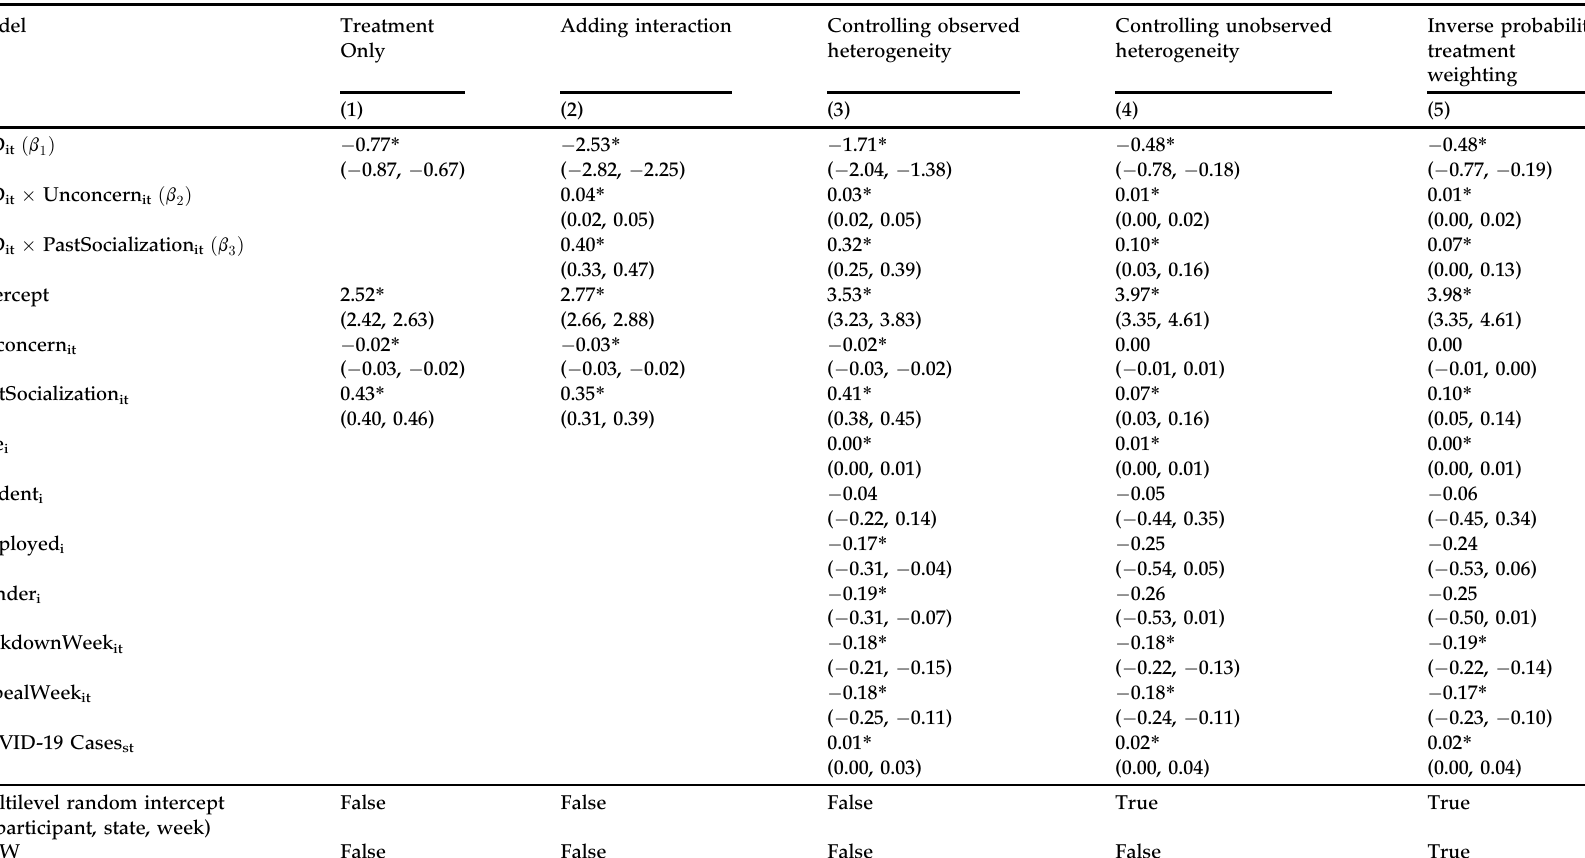
Table 5. Estimation results.